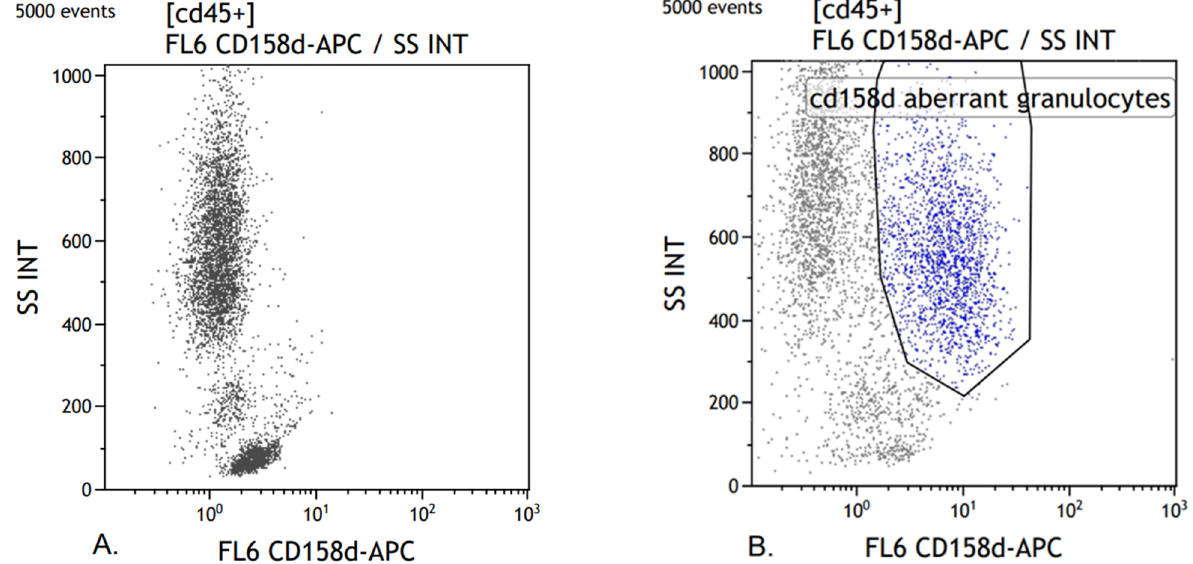
Figure 1. FCM scatterplots for CD158d: ( A ) sample from HCs; ( B ) sample from a patient with an aberrant expression of CD158d in the granulocyte population, with CD158d+ granulocytes gated.